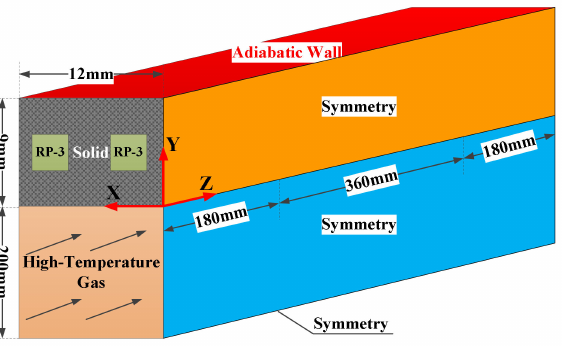
Figure 4. Computational domain.